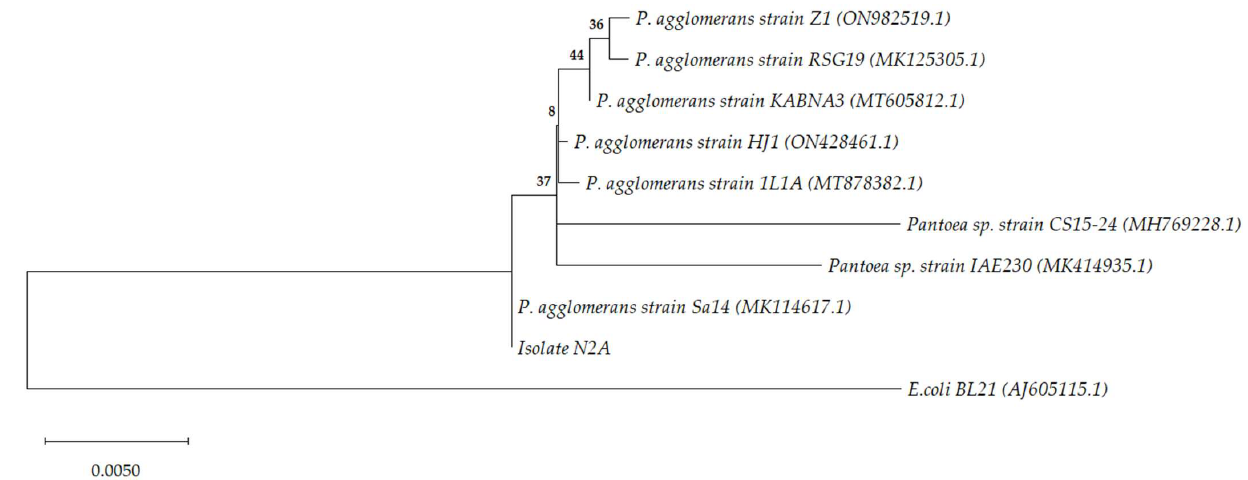
Figure 9. Phylogenetic tree inferred using the maximum likelihood method and Jukes–Cantor model [38]. The tree with the highest log likelihood (−2671.15) is shown. The percentage of trees in which the associated taxa clustered together is shown next to the branches. The tree is drawn to scale, with branch lengths measured in the number of substitutions per site. This analysis involved 10 nucleotide sequences. There were a total of 1488 positions in the final dataset. NCBI accession numbers are provided in parenthesis.